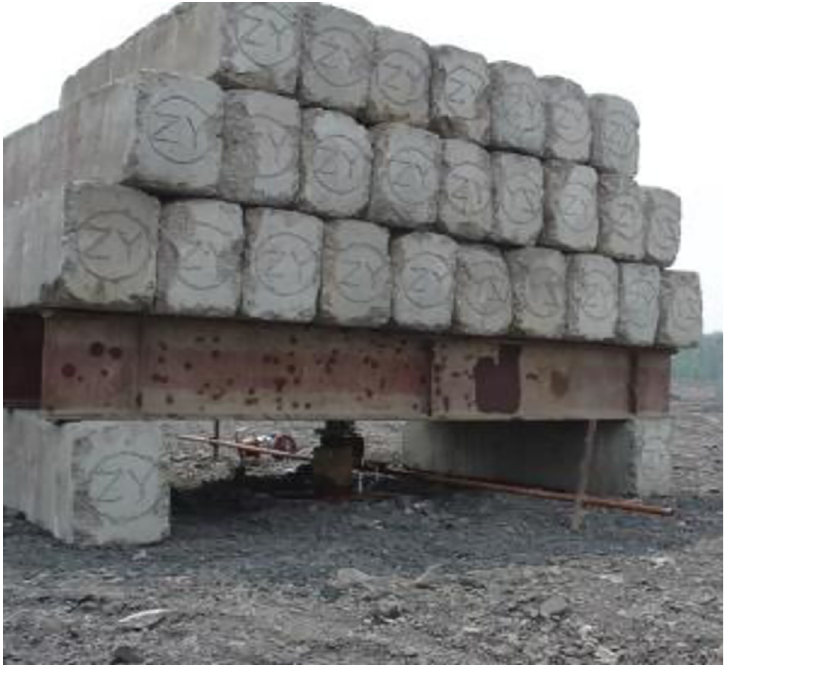
Fig 13. The static loading